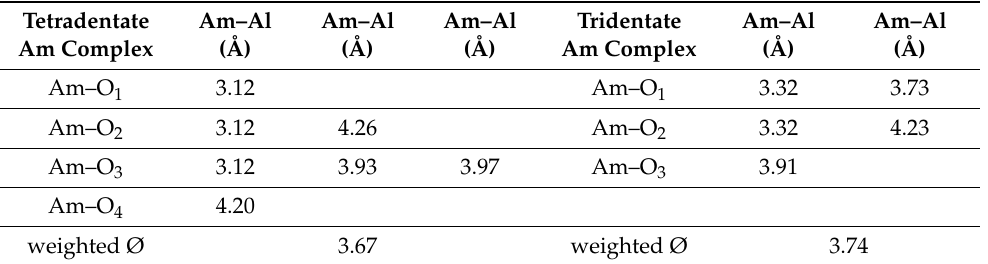
Table 3. Computed Am–Al distances for the tetradentate and tridentate Am complexes on the corundum